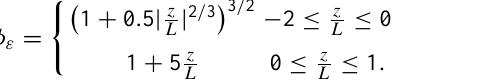
Fig. 10. Chart of the normalized TKE dissipation rate during daytime (diamond-shaped) and night (dot). Plot CT, level 5, 25 July 1997, through